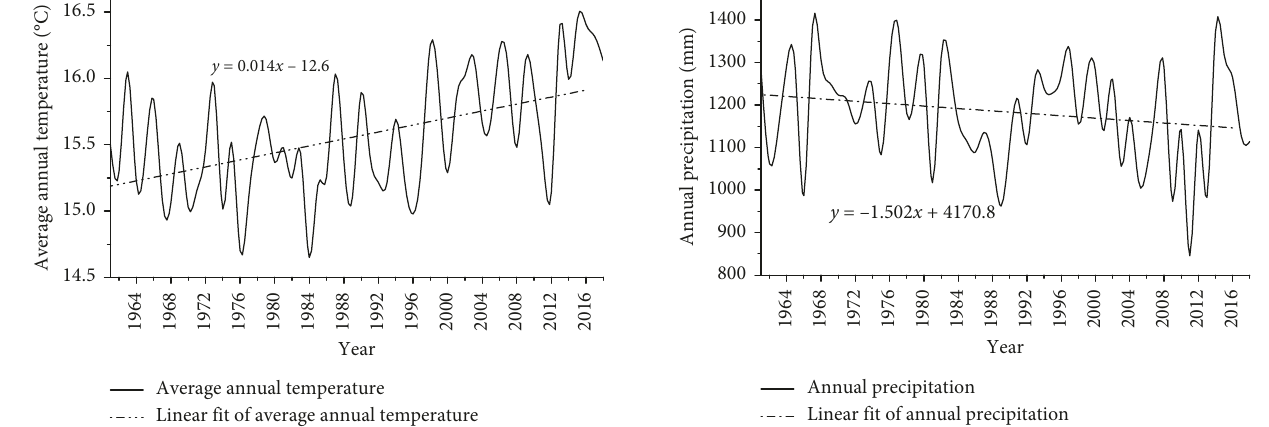
Figure 6: Evolution trends of the average annual temperature from 1961 to 2018.